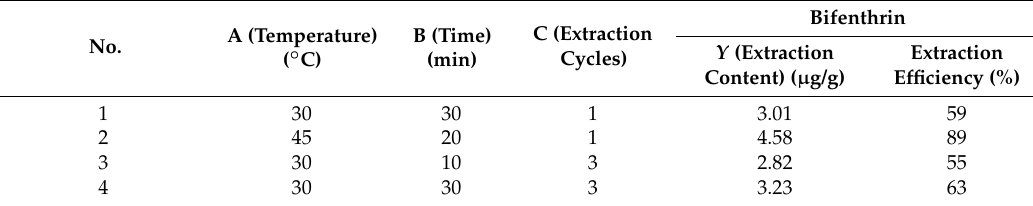
Table 1. The design of Box-Behnken and the response values for bifenthrin extract content.